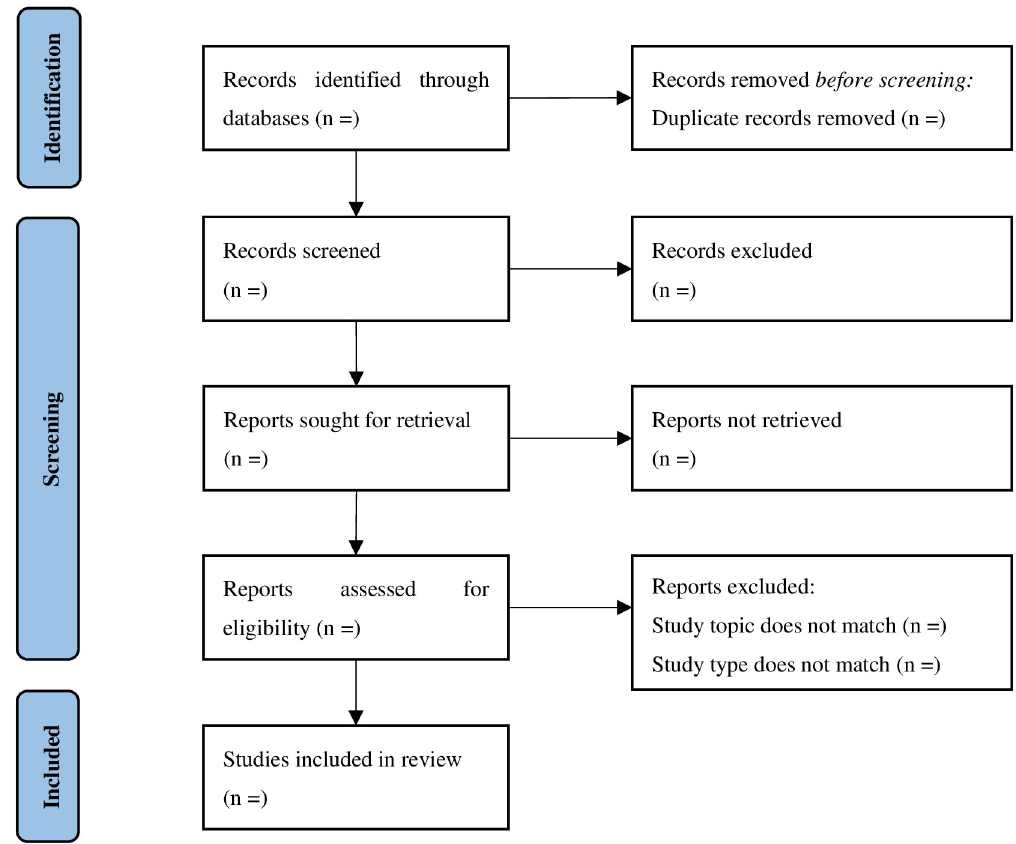
Fig 1. Flow diagram of study